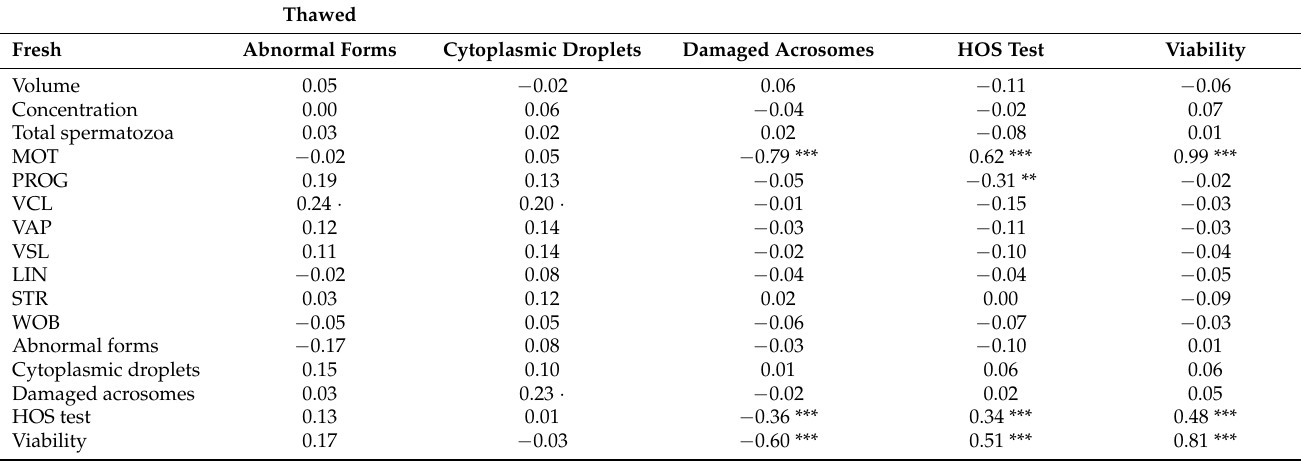
Table 3. Correlation analysis (Pearson r) between fresh and post-thawing parameters for the Asturiana de la Montaña bulls (continued from Table 2).